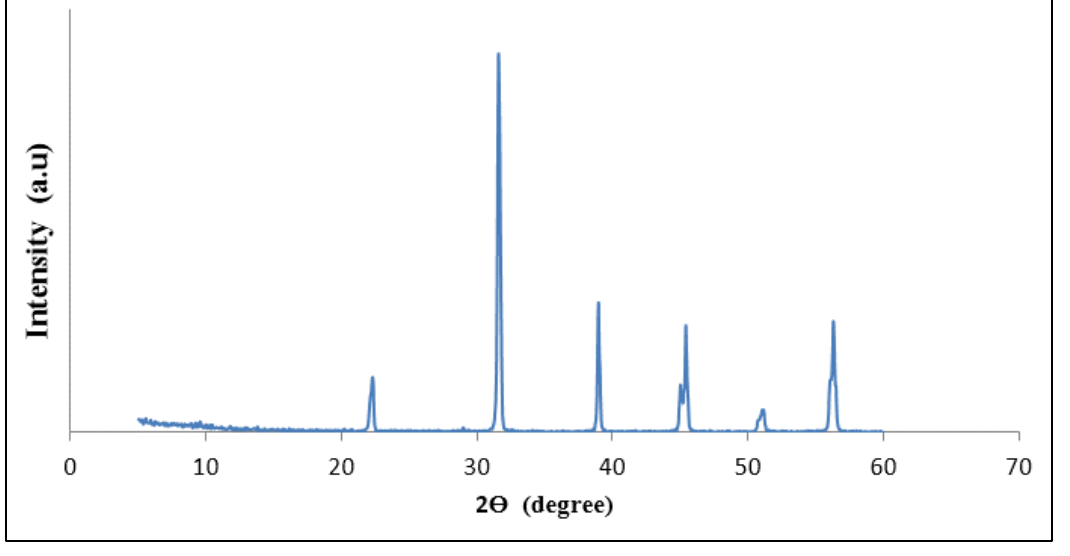
Figure 9: Barium Titanate XRD pattern at 1200 ° C. So as it can be seen they are widened gradually and lastly split during an increase in the sintered temperature. This phenomenon refers to the (tetragonal structure) of Barium Titanate (BaTiO 3 ) phase was formed well with the increase in sintered temperature [24]. As shown in Figure